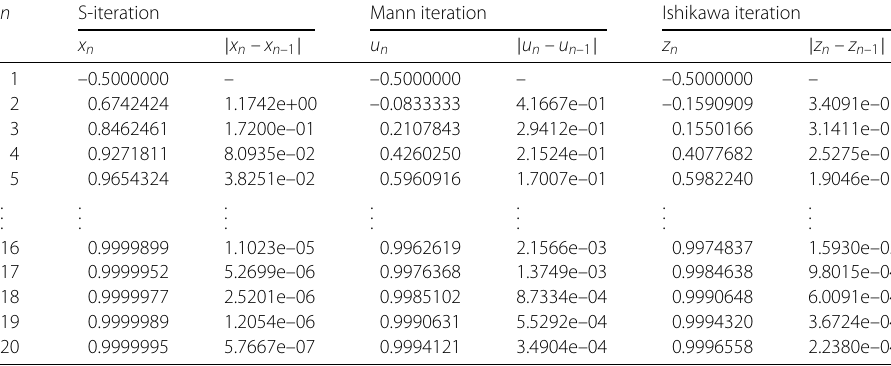
Table 1 Iterates of S-iteration, Mann iteration, and Ishikawa iteration for x 1 = u 1 = z 1 = –0.5